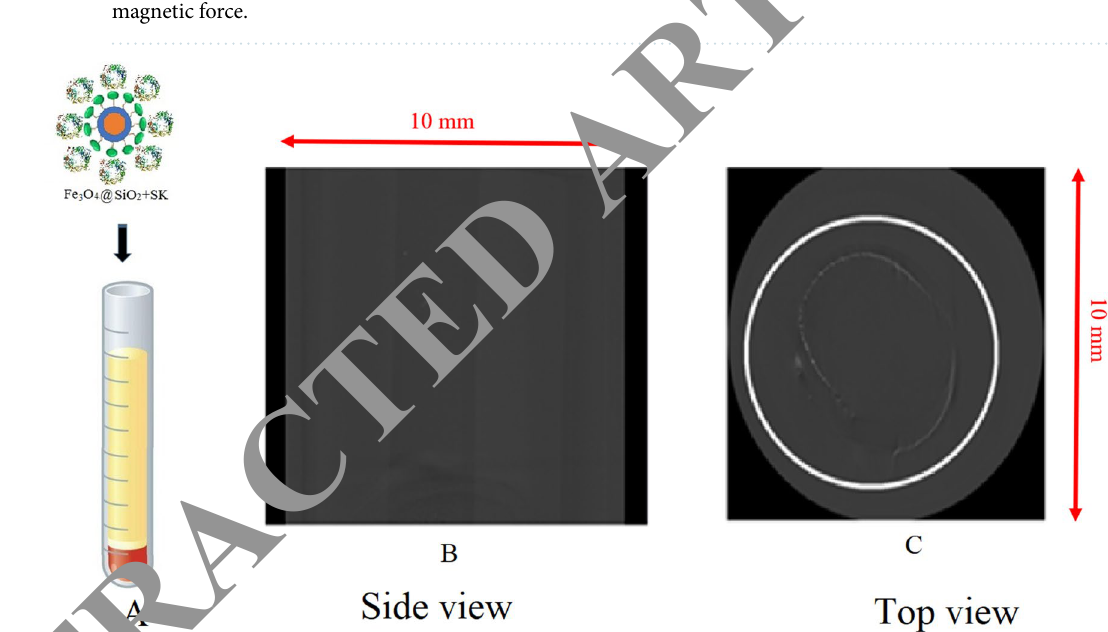
Figure 8. Micro CT-scan image clot without magnetic field. ( A ) Schematic of applying magnetic field on clot and magnetic nanoparticles. ( B ) Side view. ( C ) Top